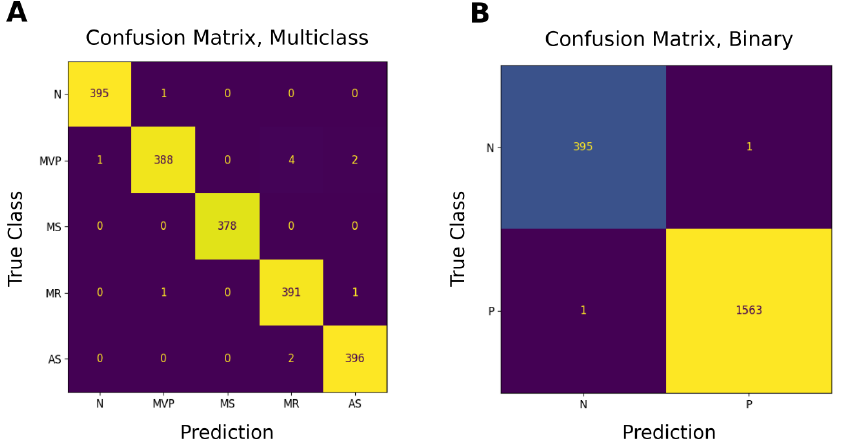
Figure 10. DL performance results (20% of dataset as training/testing set): ( A , B ) Confusion matrices for multiclass and binary classification respectively